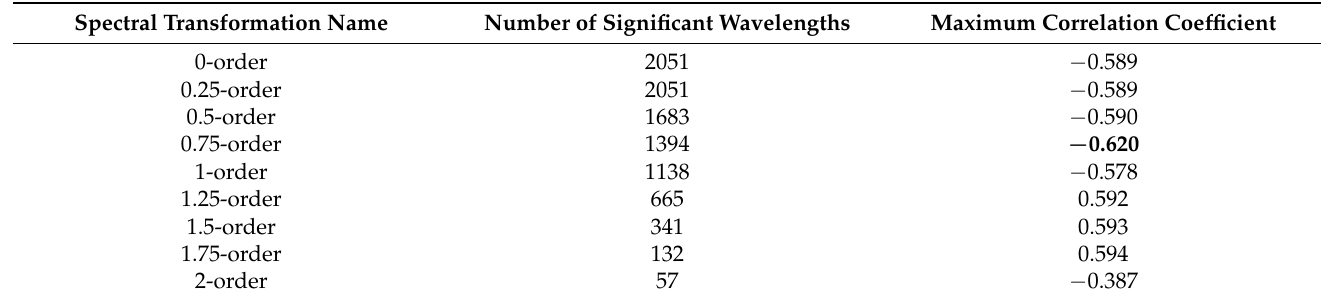
Table 4. The number of wavelengths passing the significance test ( p < 0.01) and the maximum correlation coefficient for different order in FOD.